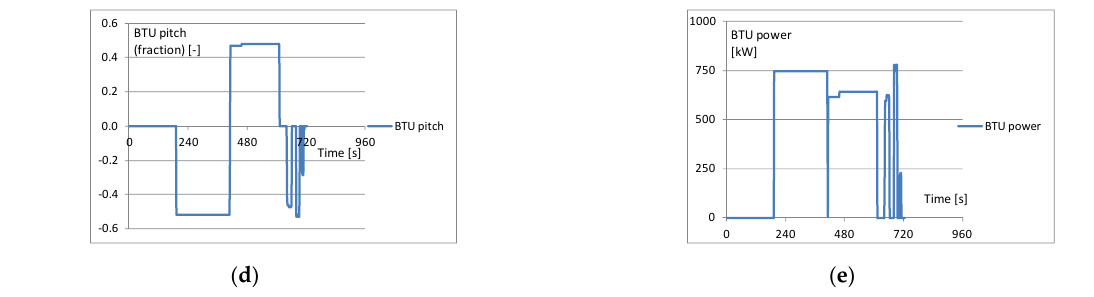
Figure 11. Representative time history of basic kinematic parameters of ferry test manoeuvre—independent steering case ‘ind #3’: ( a ) main propeller pitch ratios (–); ( b ) main propeller powers (kW); ( c ) rudder angles (°); ( d ) BTU pitch (fraction of max., i.e., ∈ [ − 1; +1]); ( e ) BTU power (kW).